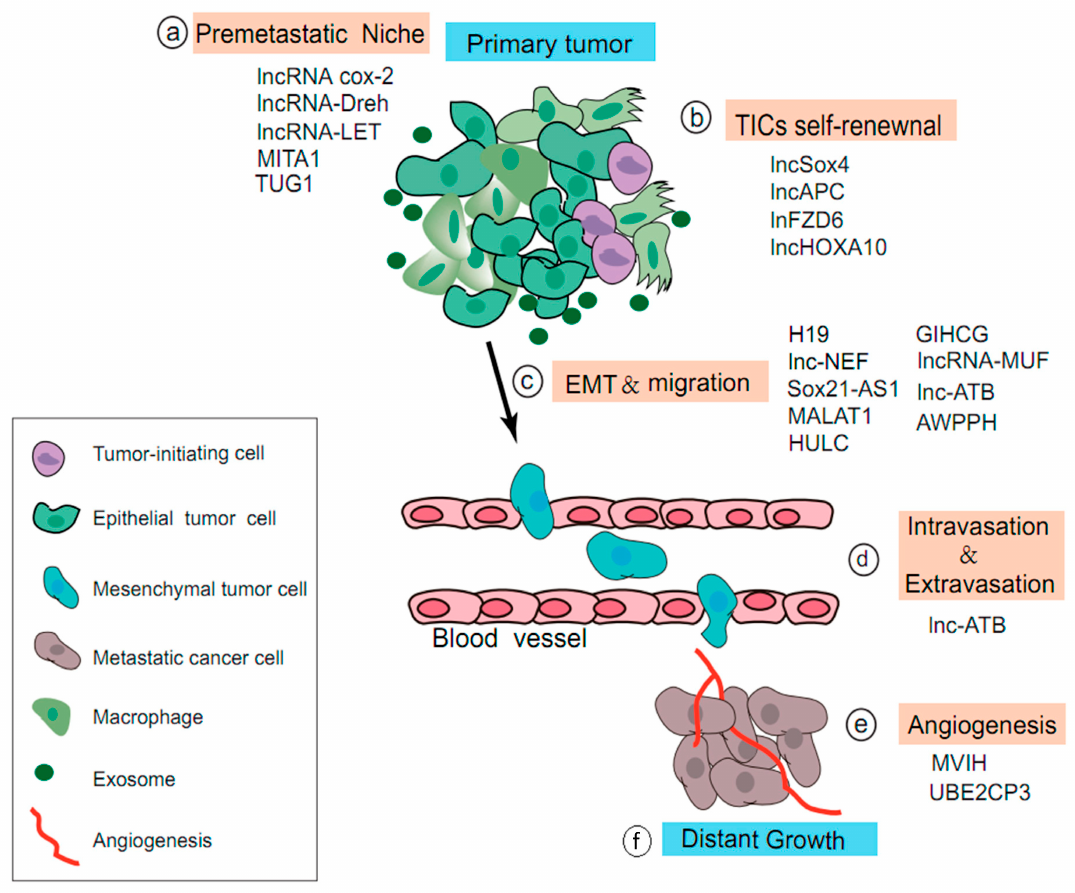
Figure 2. LncRNAs in the multi-step process of HCC metastasis. LncRNAs exert diverse regulatory roles in the multi-step metastasis of HCC, including ( a ) the pre-metastasis niche (e.g., lncRNA cox-2 and MITA1), ( b ) TIC self-renewal (e.g., lncSox4 and lncFZD6), ( c ) EMT and migration (e.g., H19 and Sox21-AS1), ( d ) intravasation and extravasation (e.g., lnc-ATB), ( e ) angiogenesis (e.g., H19 and Sox21-AS1), and ( f ) distant growth (e.g., MVIH and UBE2CP3). In the pre-metastasis niche, lncRNA cox-2 prohibits immune evasion and metastasis of HCC by impeding the polarization of M1/M2 macrophages [69]. The hepatitis B virus X protein (HBx)-related lncRNA down-regulated expression by HBx (lncRNA-Dreh) attenuates HCC metastasis by targeting